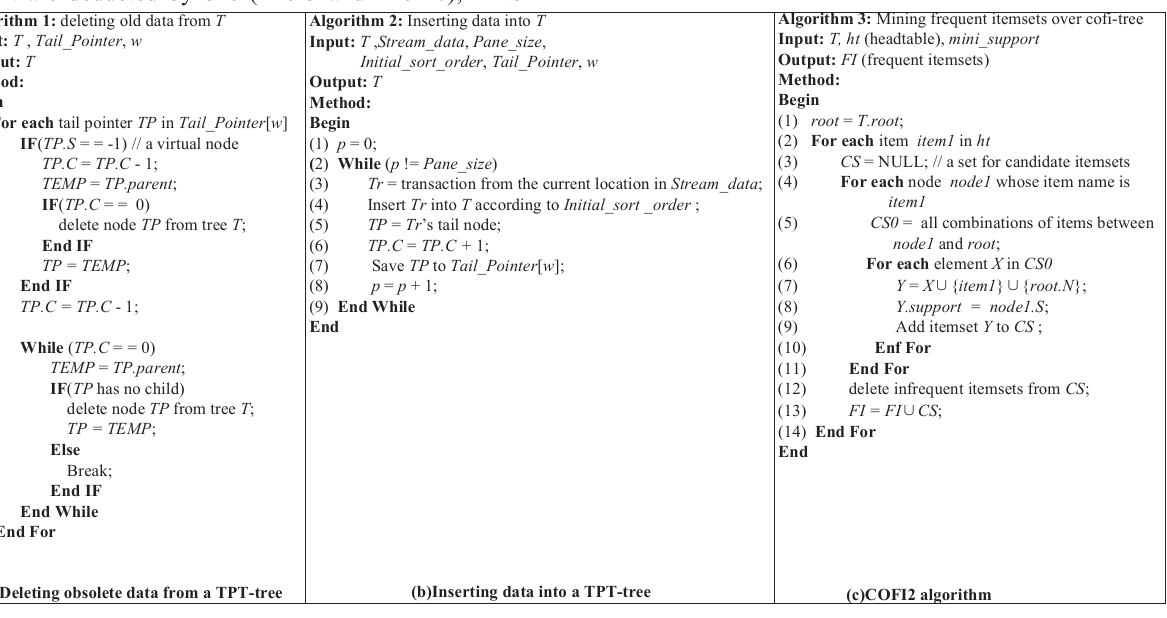
Fig. 5. Algorithms based on TPT-tree and COFI2